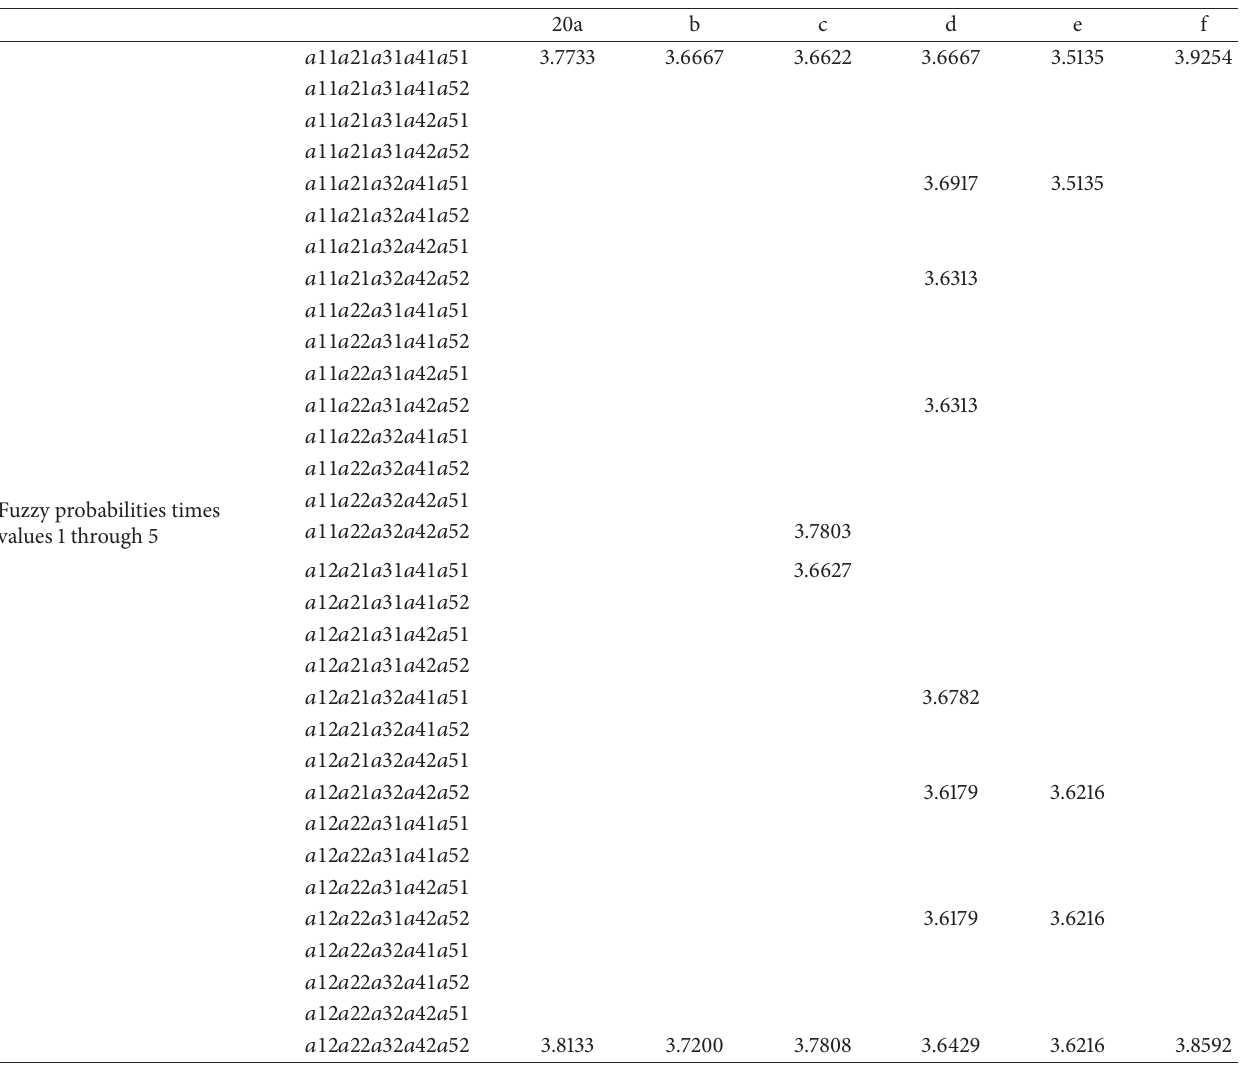
Table 5: Fuzzy probabilities for Question 20 multiplied by associated scores (1–5) and summed for each usable